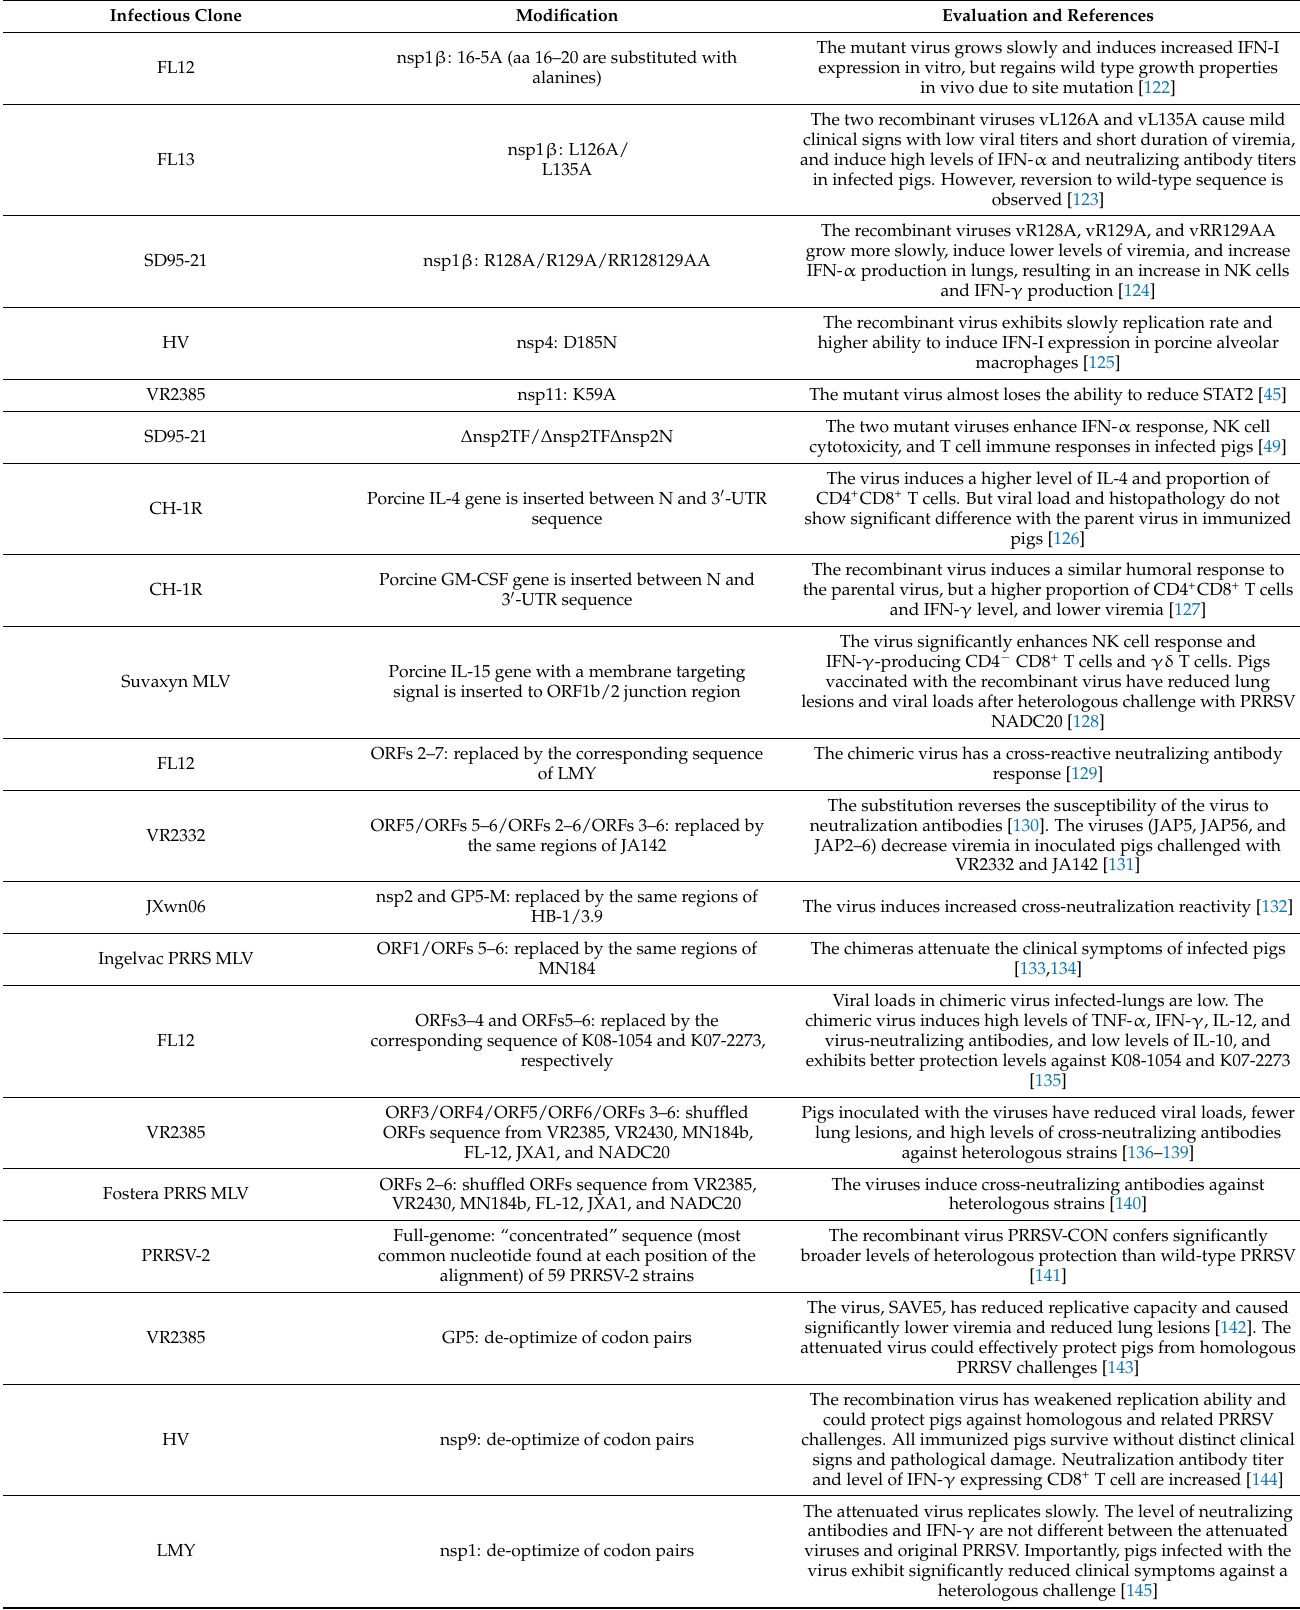
Table 1. Application of reverse genetics in the development of PRRSV modified live vaccines